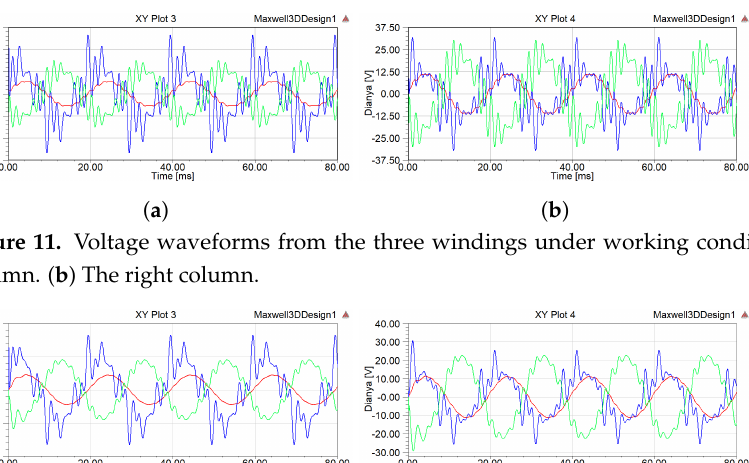
Figure 10. Voltage waveforms from grid-side and valve-side windings under working condition 1. ( a ) The left column. ( b ) The right column.